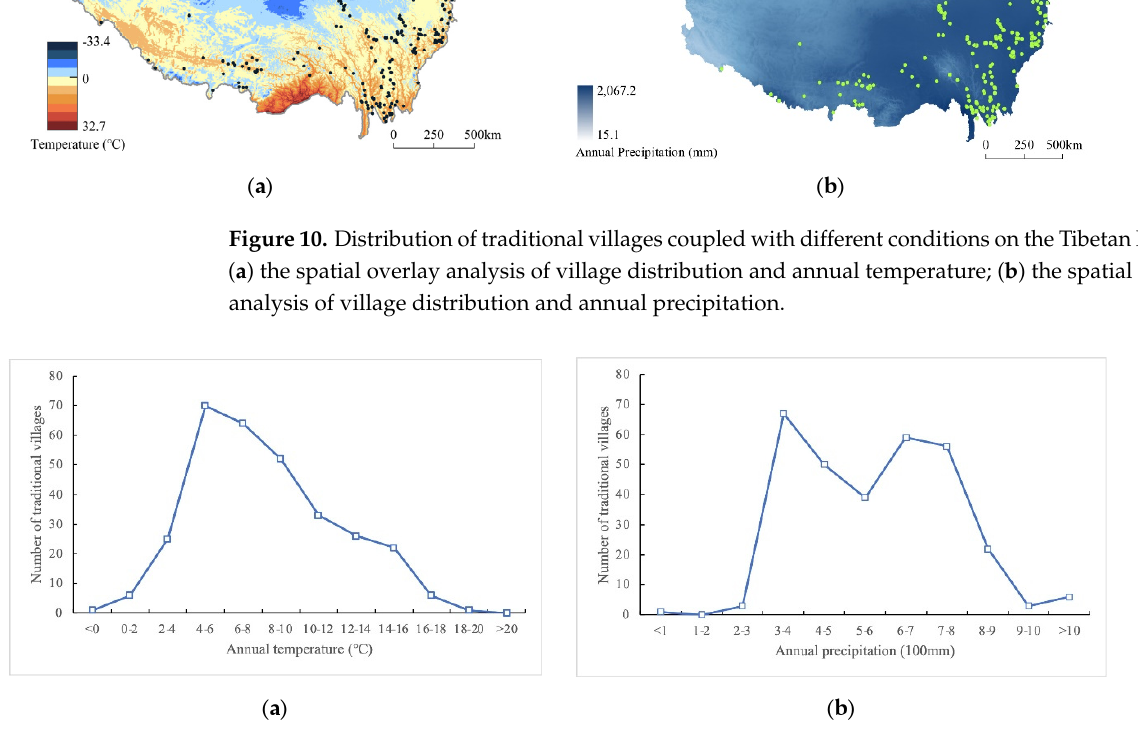
Figure 11. Statistics of traditional villages on the Tibetan Plateau in different annual conditions: ( a ) temperature; ( b ) precipitation .